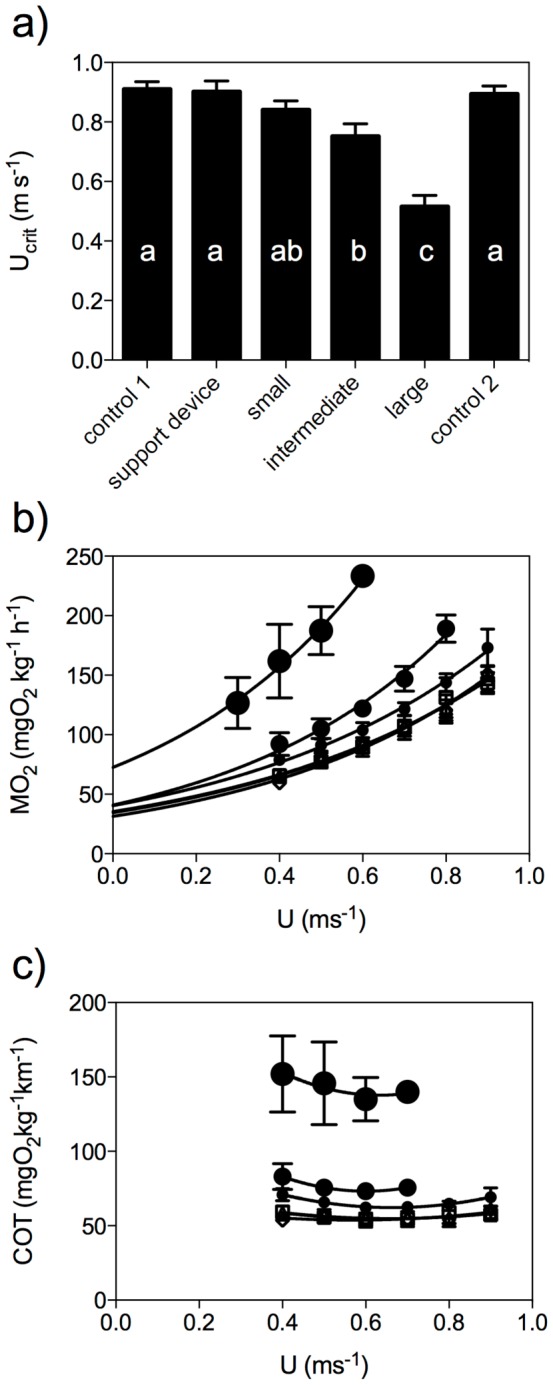
Swimming energetic parameters with attachment site.a) Critical swimming speed (Ucrit), b) relative oxygen consumption (MO2, mgO2kg−1h−1) and c) Cost Of Transport (COT, mgO2kg−1m−1), both as a function of swimming speed (U, m s−1) for control (□), and for eels carrying an intermediate dummy at site A (•) and B (○). Exponential function MO2  =  SMRecU, with SMR the standard metabolic rate, e Euler's constant and c constant, and U swimming speed (for values see table 1). Data are mean±SE, repeated measures ANOVA, p<0.05, N = 8, r2>0.9, * indicates significant difference from control at the respective speed.